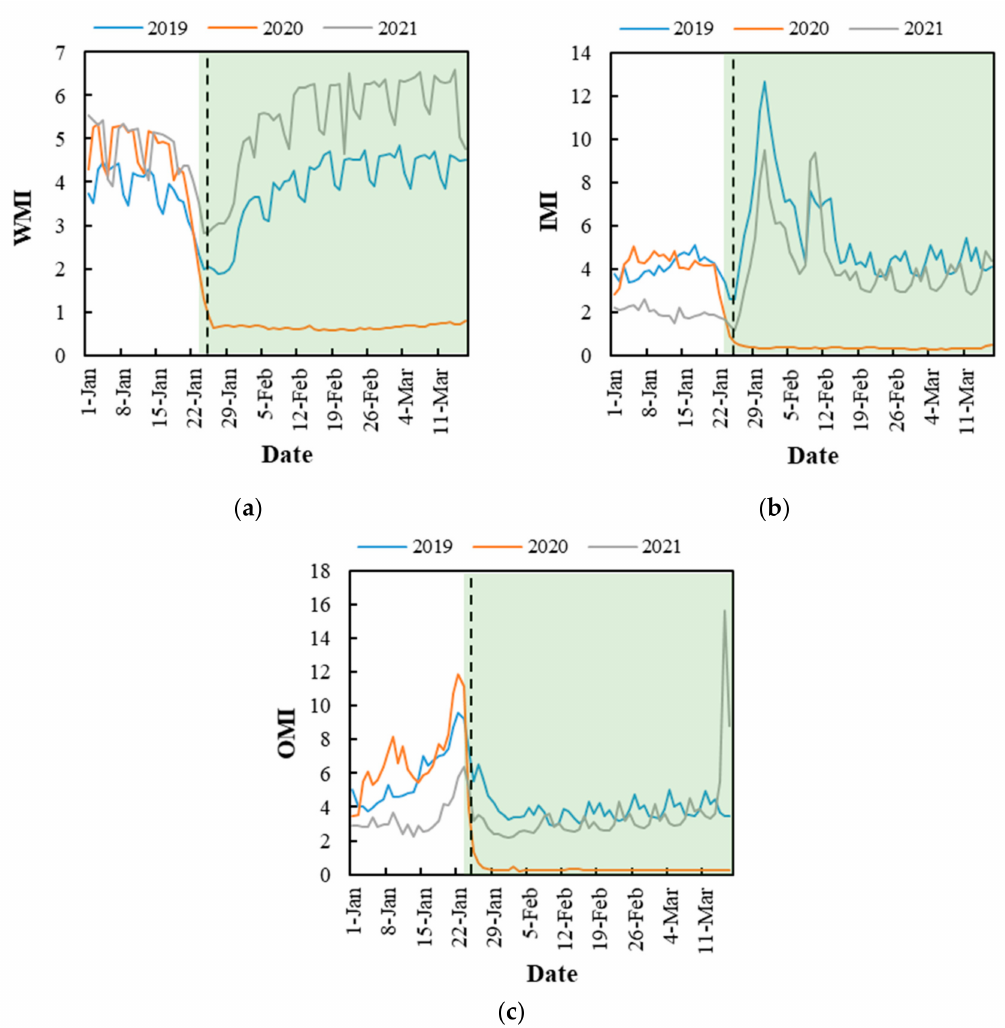
Figure 4. Changes in human mobility over three years: ( a ) WMI; ( b ) IMI; ( c ) OMI (The black dashed vertical line means the date of the Spring Festival and the green area means the lockdown period in our study. The daily In-Migration Index (IMI) and Out-Migration Index (OMI) represent the inflow and the outflow traffic volume, and the daily Within-City Migration Index (WMI) represents human traffic mobility within the